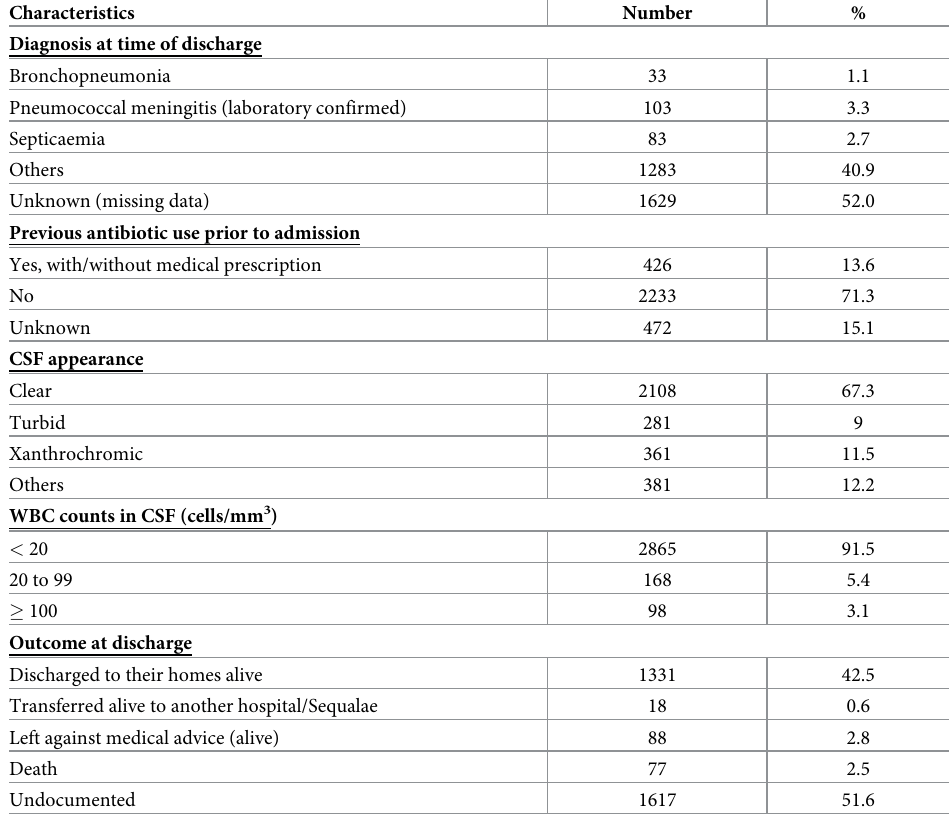
Table 3. Clinical and laboratory outcomes of children aged 2 – 59 months evaluated for suspected meningitis admitted at the sentinel surveillance hospitals in Yaounde´: 2011—2018 (N = 3131).